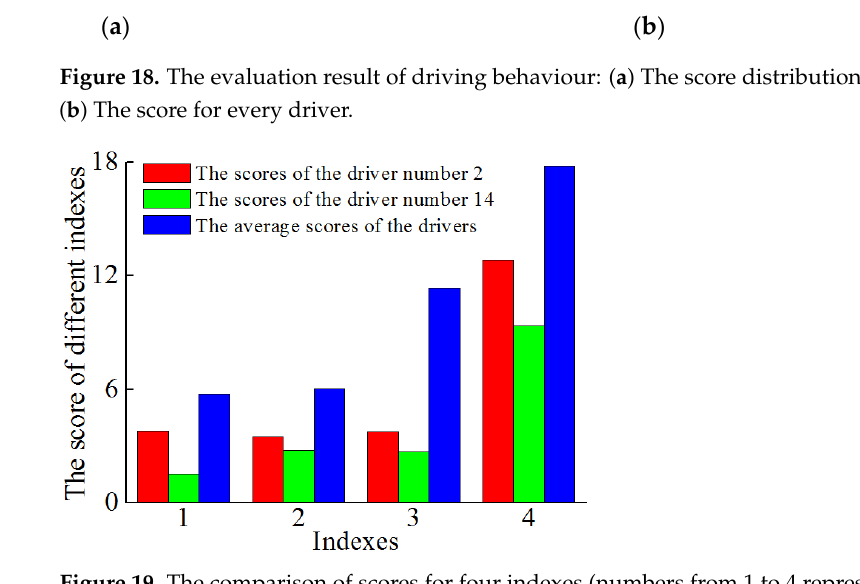
Figure 19. The comparison of scores for four indexes (numbers from 1 to 4 represent the number of rapid accelerations per 100 km, the number of sudden brakings per 100 km, the number of rapid turns per 100 km and the number of speeding occurrences during steering per 100 km, respective- ly).